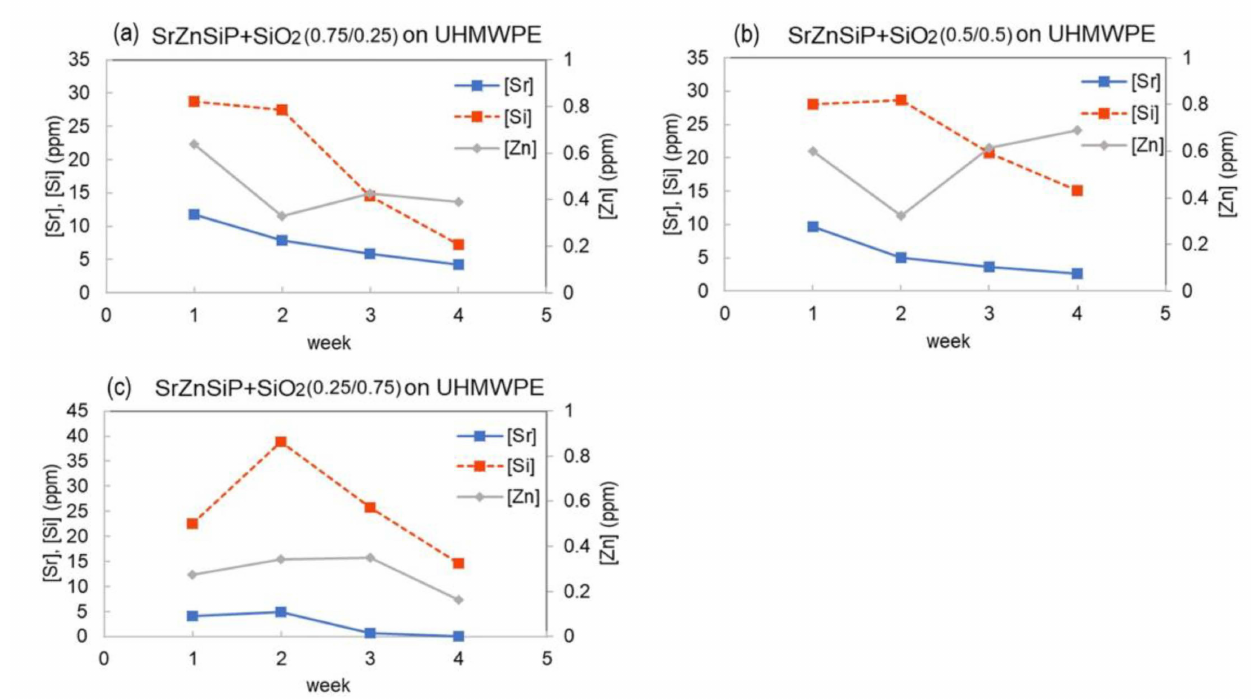
Figure 14. Comparison of dissolution behaviors of binary coatings of ( a ) a mixture of SrZnSiP and SiO 2 (0.75/0.25); ( b ) a mixture of SrZnSiP and SiO 2 (0.5/0.5); and ( c ) a mixture of SrZnSiP and SiO 2 (0.25/0.75) during immersion in water for four